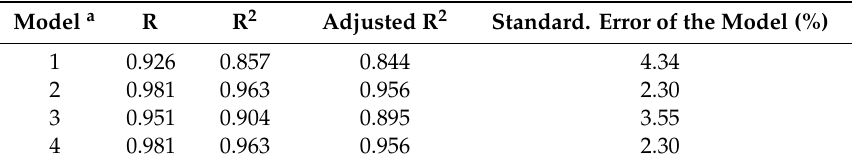
Table 8. Linear Regression of Firmness of Beans with RVA